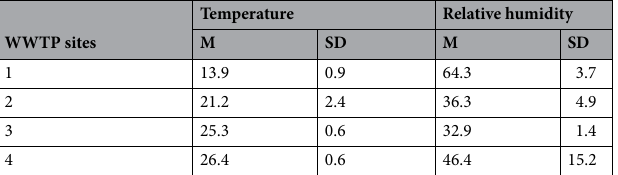
Table 5. Temperature and relative humidity of the air at examined WWTP sampling sites. M arithmetic mean value, SD standard deviation, 1 wastewater pumping section, 2 screens section, 3 grit chamber section, 4 dewatering/thickening sludge